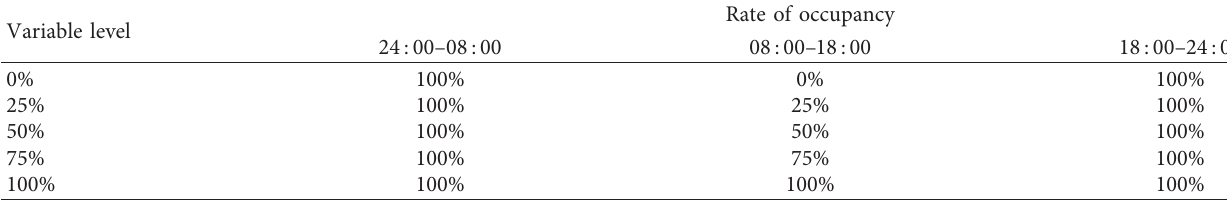
Table 8: Setting of schedules in a